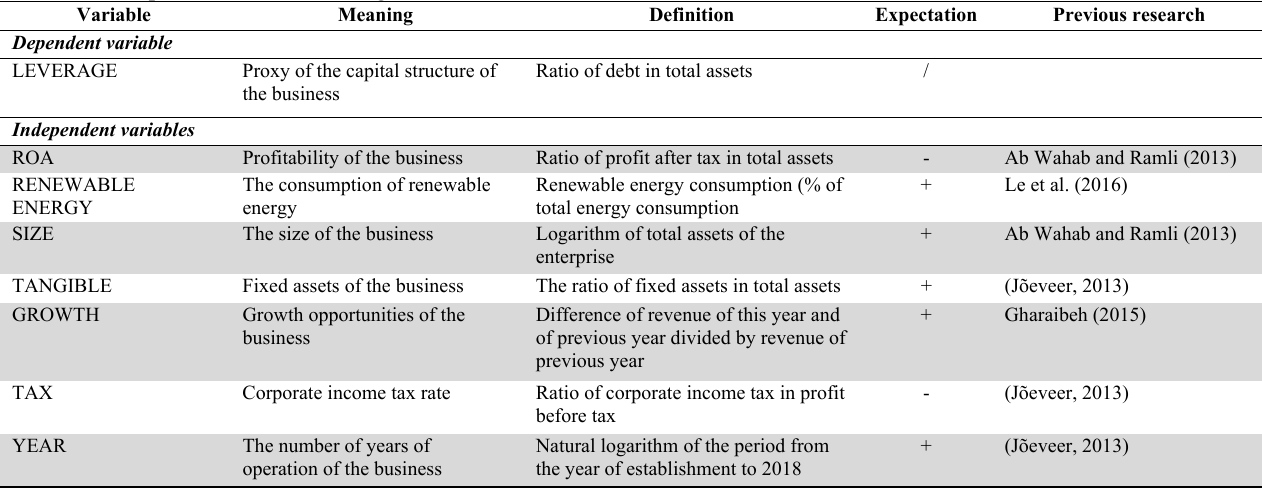
Detailed description of variables in regression